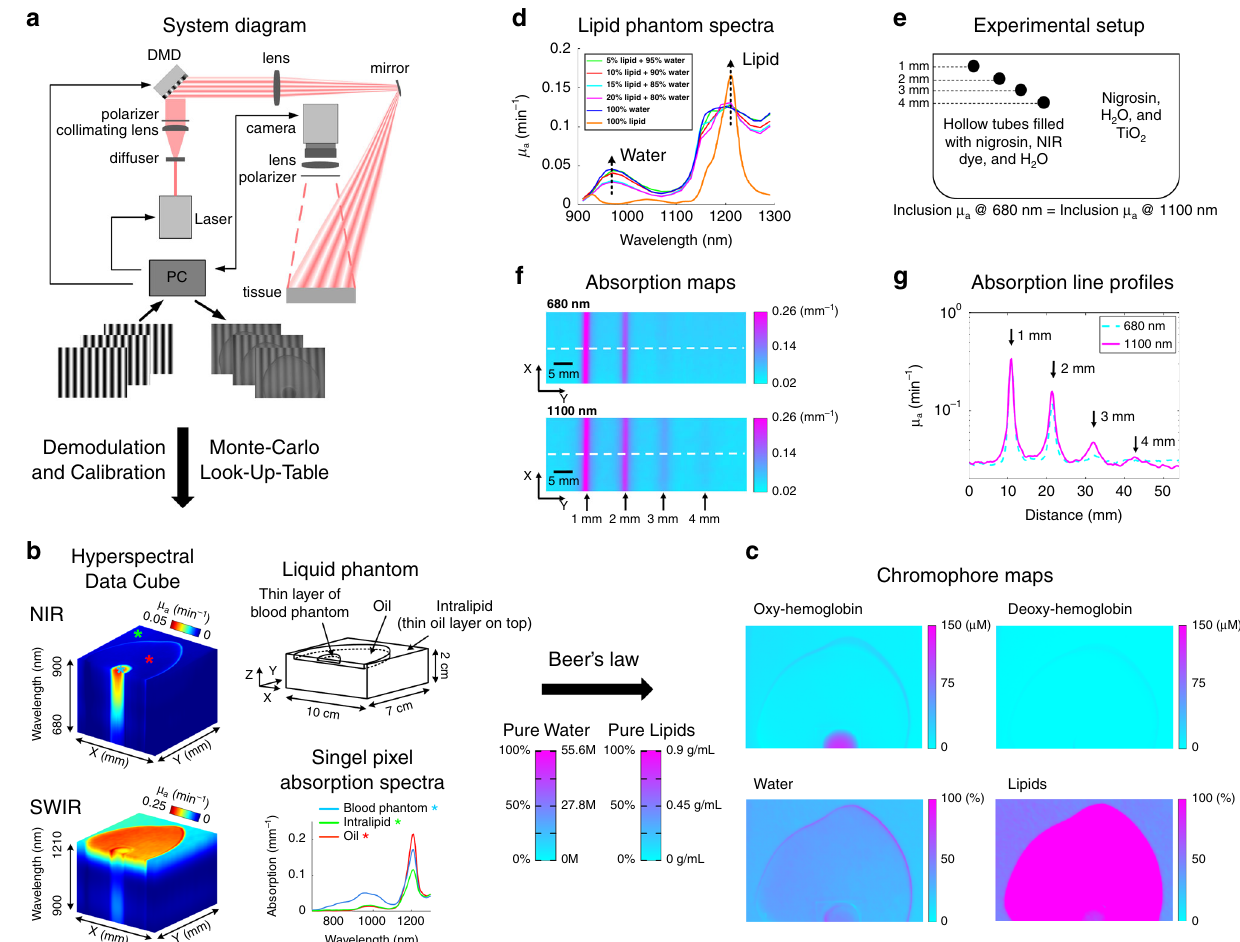
Fig. 1 Hyperspectral SWIR-MPI system design and data fl ow. a A tunable NIR-SWIR laser illuminates a digital micromirror device (DMD) to generate meso-scale illumination patterns which are then projected onto the sample plane. Remitted light is collected by a germanium CMOS camera. b Raw re fl ectance images are demodulated to extract the tissue response at spatial frequencies of interest, in this case 0 mm − 1 and 0.1 mm − 1 . A Monte Carlo based inversion model is used to extract optical properties (absorption and reduced scattering) on a pixel-by-pixel basis for each illumination wavelength to generate hyperspectral data cubes. Here, a liquid phantom (10 × 7 × 2 cm) was fabricated with an intralipid base partially coated with a layer of soybean oil and a thin layer of a blood (oxyhemoglobin)/TiO 2 mixture. A thin layer of oil was formed on top of the intralipid base due to diffusion. Hyperspectral absorption ( µ a (mm − 1 )) data cubes are shown for the NIR and SWIR wavelengths bands. Hemoglobin absorption contrast is clearly apparent in the NIR region but only to a small degree in the SWIR region, whereas water and lipid contrast are both apparent in the SWIR band. c 2D maps of oxyhemoglobin, deoxyhemoglobin, water, and lipid concentrations are shown, highlighting the ability of SWIR-MPI to extract the spatial mosaic of chromophores present in the phantom. Following common practice in the diffuse optical spectroscopy fi eld, water and lipid concentrations are reported as percentages (%) 20 . d Optical absorption ( µ a ) spectra of water-lipid phantoms over a range of concentrations; 100% water and lipid spectra are plotted for reference. e The measurement setup of a phantom imaging depth experiment (side view). f Optical absorption maps at 680 nm and 1100 nm. The absorption of the phantom was approximately equal at these two wavelengths, providing a means to compare the improved imaging depth at 1100 nm. g . Line pro fi les of the measured optical absorption corresponding to the dashed white lines in f , demonstrating improved contrast at 3 and 4 mm depths at 1100 nm. Source data are provided as a Source Data fi Phantom validation studies . Figure 1b demonstrates the ability The spectrum from the thin layer of blood also exhibits this of SWIR-MPI to extract a complex spatial mosaic of chromo- lipid absorption feature, demonstrating a partial volume effect phores in an optical phantom. In this example, a liquid phan- owing to the nature of diffusive photons, in which absorption tom was fabricated from intralipid (an emulsi fi ed water/lipid from different tissue regions within the optical probing volume solution), bovine blood, and soybean oil, with hyperspectral are effectively averaged. Figure 1c shows measured concentra- optical absorption data cubes generated for both NIR and SWIR tion maps of oxyhemoglobin, deoxyhemoglobin, water, and wavelength regions. Areas containing hemoglobin show distinct lipids in the optical phantom. Following common practice absorption features at NIR wavelengths, whereas the areas with observed in the diffuse optical spectroscopy fi eld, water and soybean oil show absorption features in the SWIR. Absorption lipid concentrations are reported as percentages 20 . The water content is reported as the concentration of measured water spectra from single pixel locations highlight distinct features for divided by pure water concentration (55.6 M). The lipid con- blood, oil, and intralipid. The contribution of oxyhemoglobin centration is reported as relative to an assumed “ pure ” lipid absorption is clearly visible in the NIR region, whereas the density of 0.9 g/ml 20 . 1210 nm absorption peak of lipid is clearly visible in the SWIR.